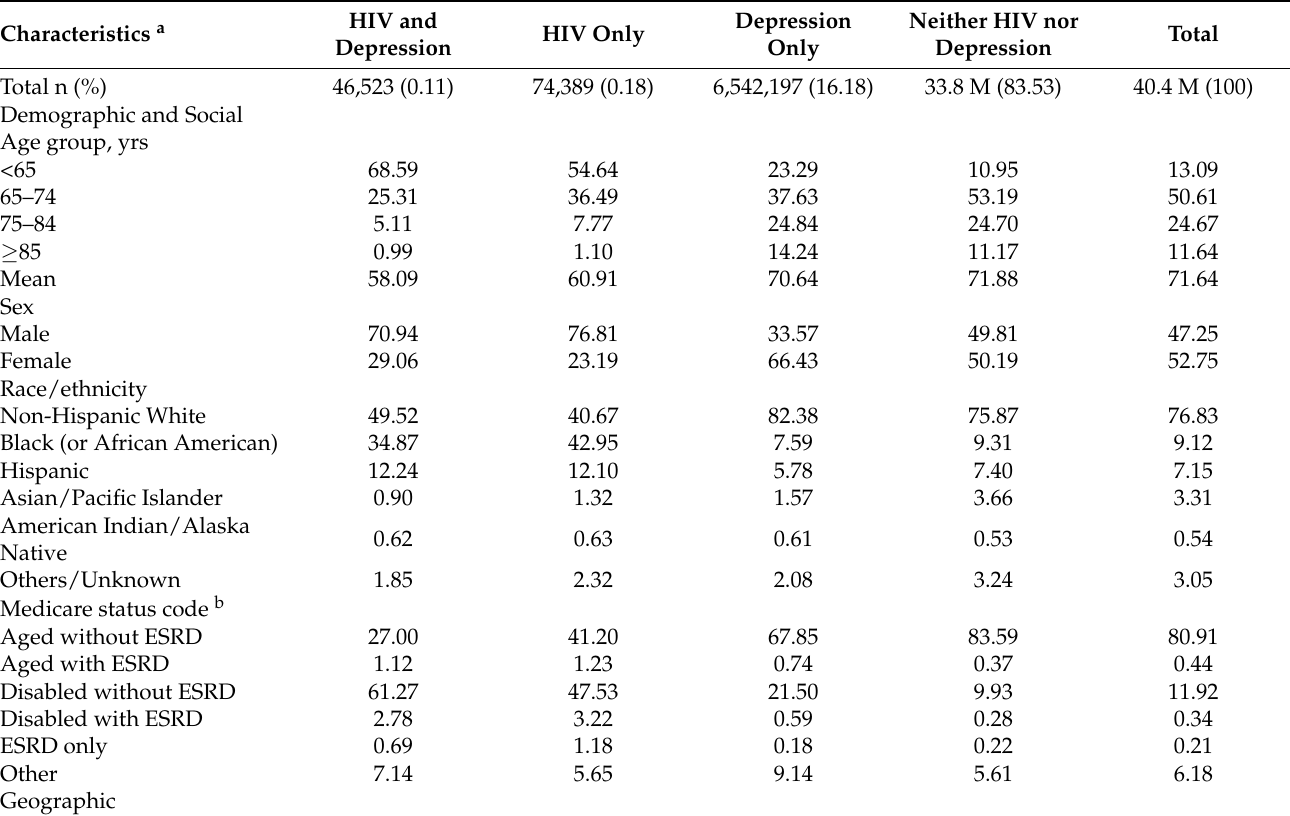
Table 1. Characteristics of Medicare beneficiaries with fee-for-service claims for HIV and depression, United States,